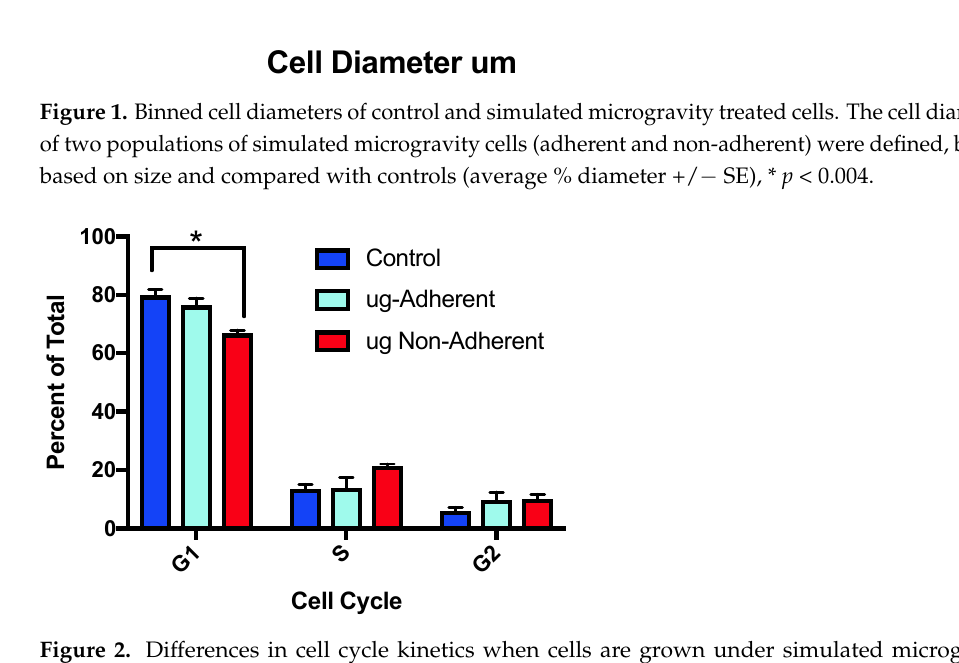
Figure 2. Differences in cell cycle kinetics when cells are grown under simulated microgravity. A significant difference in the percent of G1 cells was noted between control and sim- µ g-treated adherent cells, * p = 0.02.